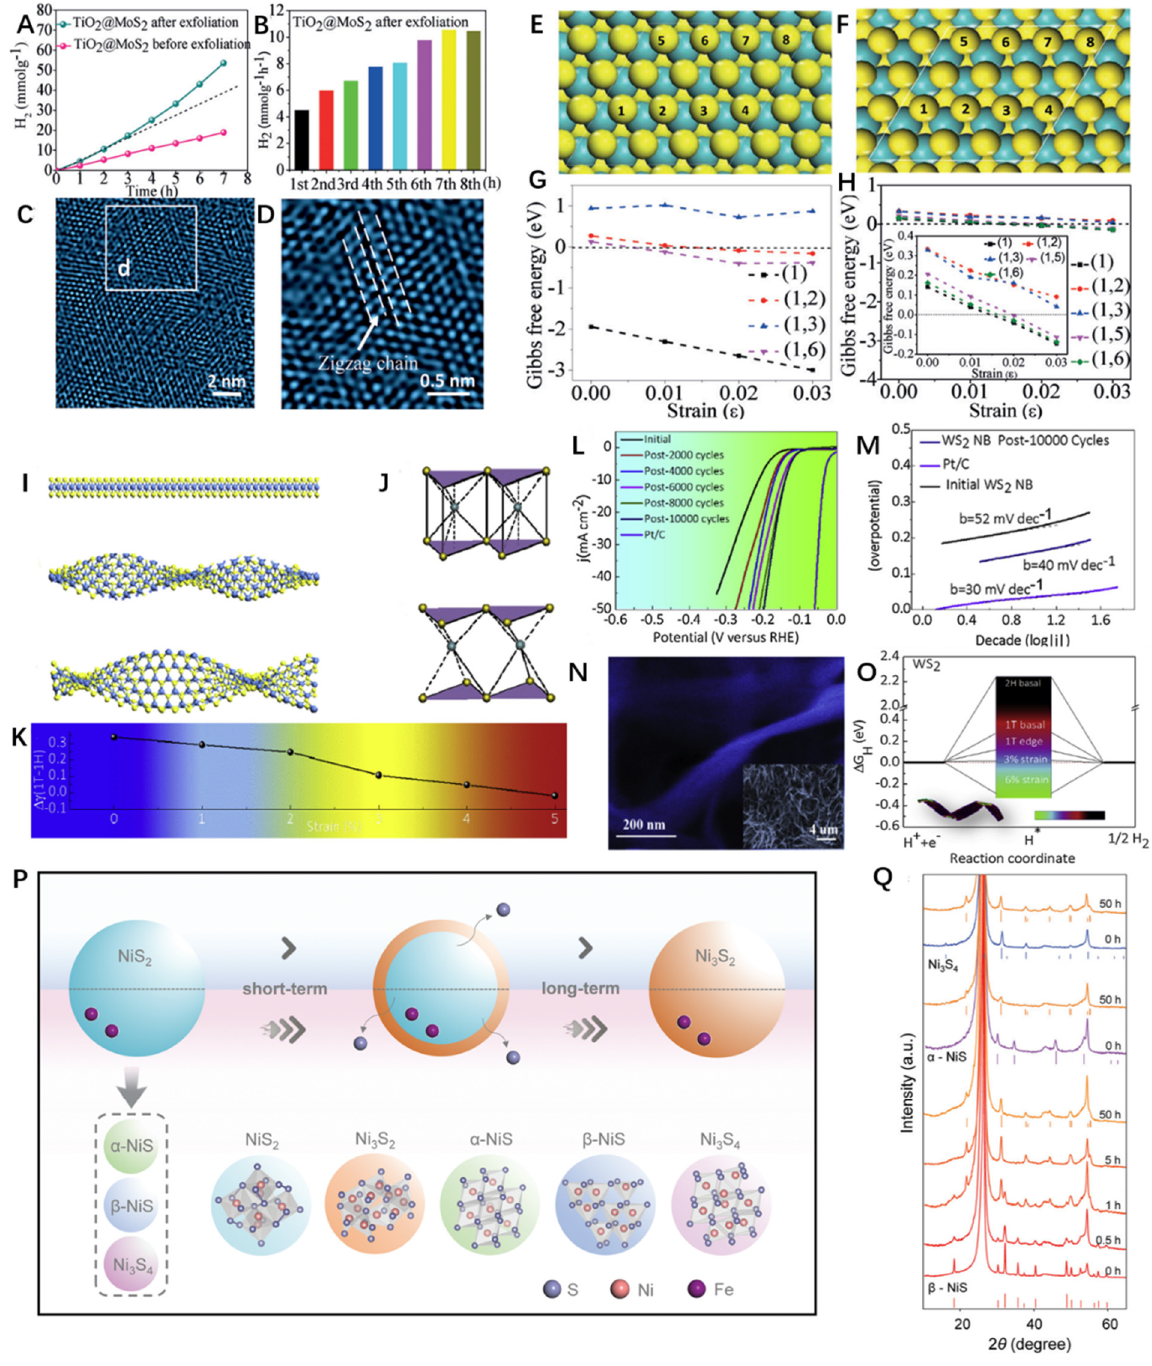
Figure 7. ( A ) H 2 accumulation and ( B ) H 2 production rate of TiO 2 @MoS 2 over stripped TiO 2 during each hour of the HER. All experiments were performed in 80 mL of a 15% ( v / v ) TEOA aqueous solution under visible light irradiation ( γ > 420 nm). ( C ) HRTEM images of MoS 2 in TiO 2 @MoS 2 exfoliated after 7 h. ( D ) Magnified image of the square in ( C ) (arrows point to the serrated chain structure of 1T’). Supercell of H adsorbed on the surface of monolayer 1T-MoS 2 ( E ) and 1T’-MoS 2 ( F ). The yellow and blue balls indicate S and Mo atoms, respectively. The numbers indicate the possible sites of H binding. The Gibbs free energy for H adsorption on 1T-MoS 2 ( G ) and 1T’-MoS 2 ( H ) was calculated for strain ( ε ) in the range of 0.0% to 3.0%. (1) corresponds to 1/16 coverage of one H at any one site. (1,2), (1,3), (1,5) and (1,6) correspond to the coverage of two H atoms (one at 1 and the other at 2, 3, 5, and 6, respectively). 1T-MoS 2 : (1,2) = (1,4); (1,3) = (1,5) = (1,7); (1,6) = (1,8). 1T’-MoS 2 : (1,2) = (1,4); (1,3) = (1,7); (1,6) = (1,8). Reproduced with permission [20], Copyright 2017, Wiley-VCH. ( I ) Strain-induced topological